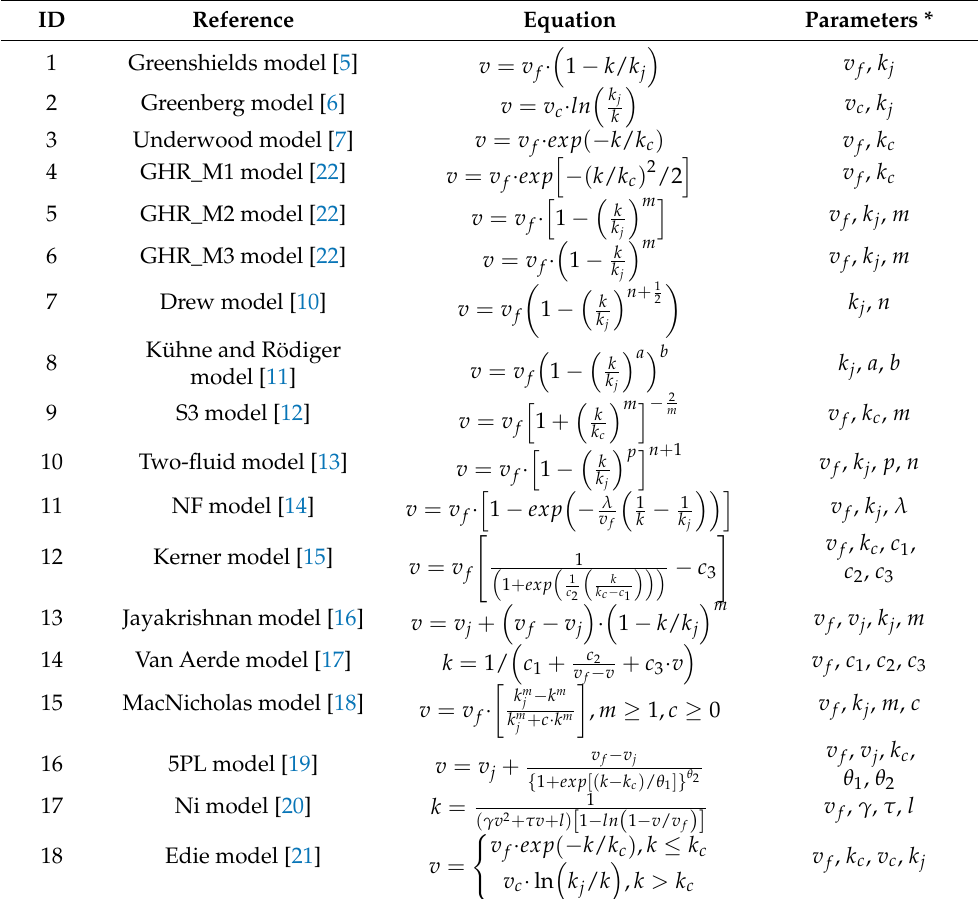
Table 1. Typical fundamental